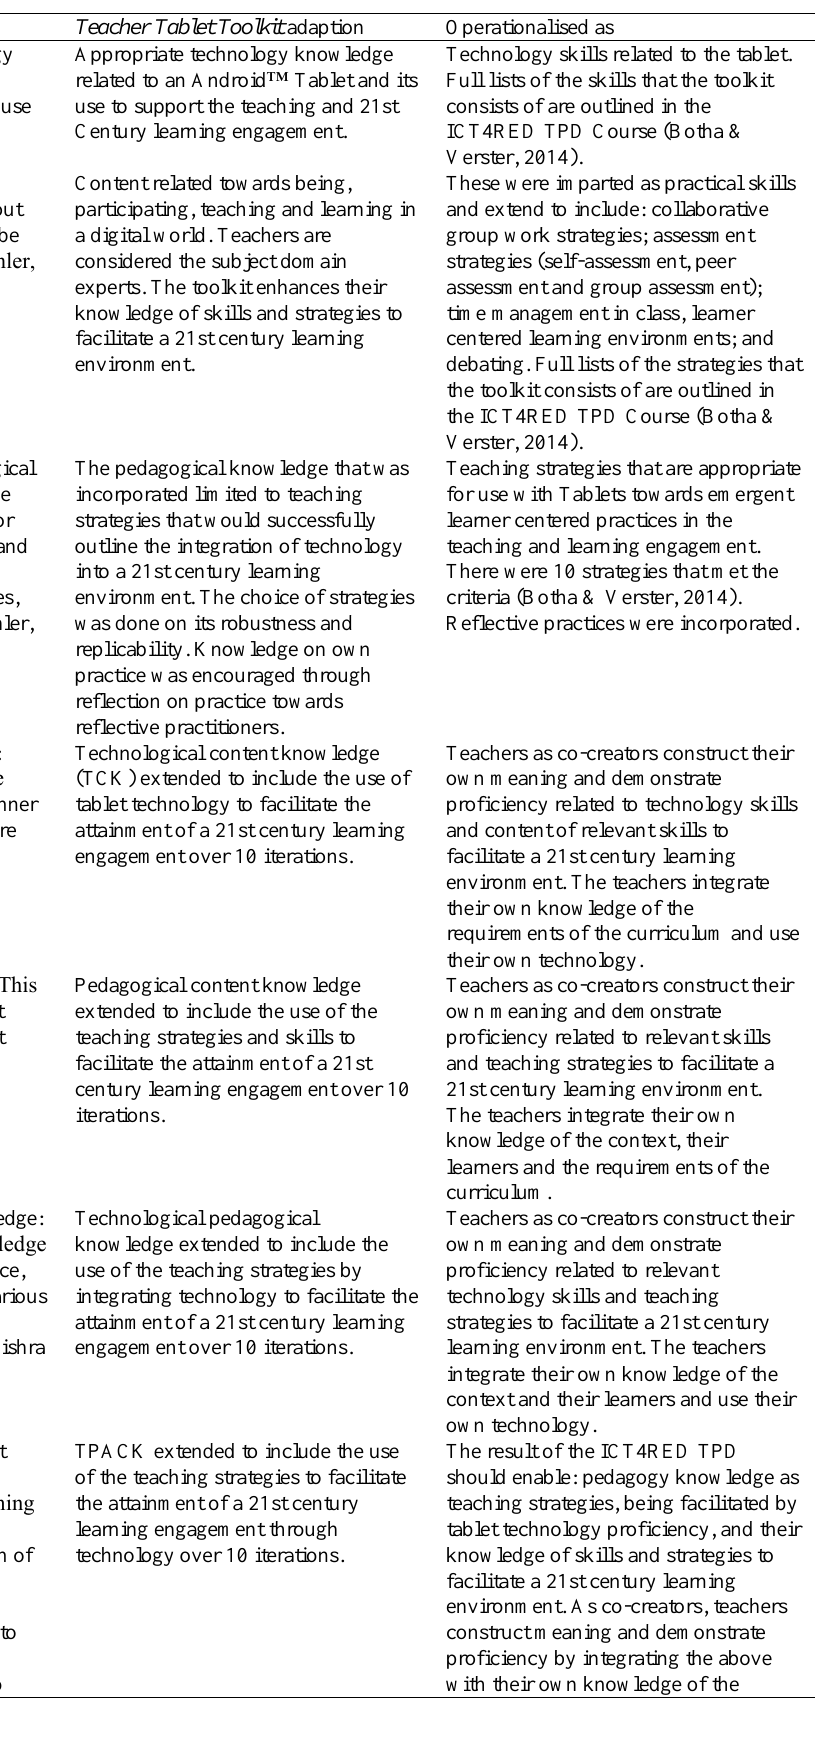
Table 2 ICT4RED pragmatic TPACK framework for the Teacher Tablet Toolkit adopted for this study